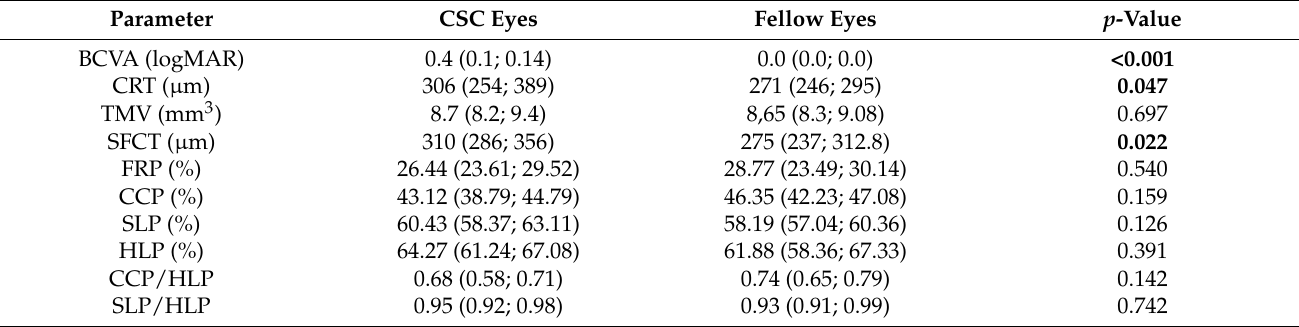
Table 2. Anatomical and functional parameters of CSC and control eyes at baseline examination.